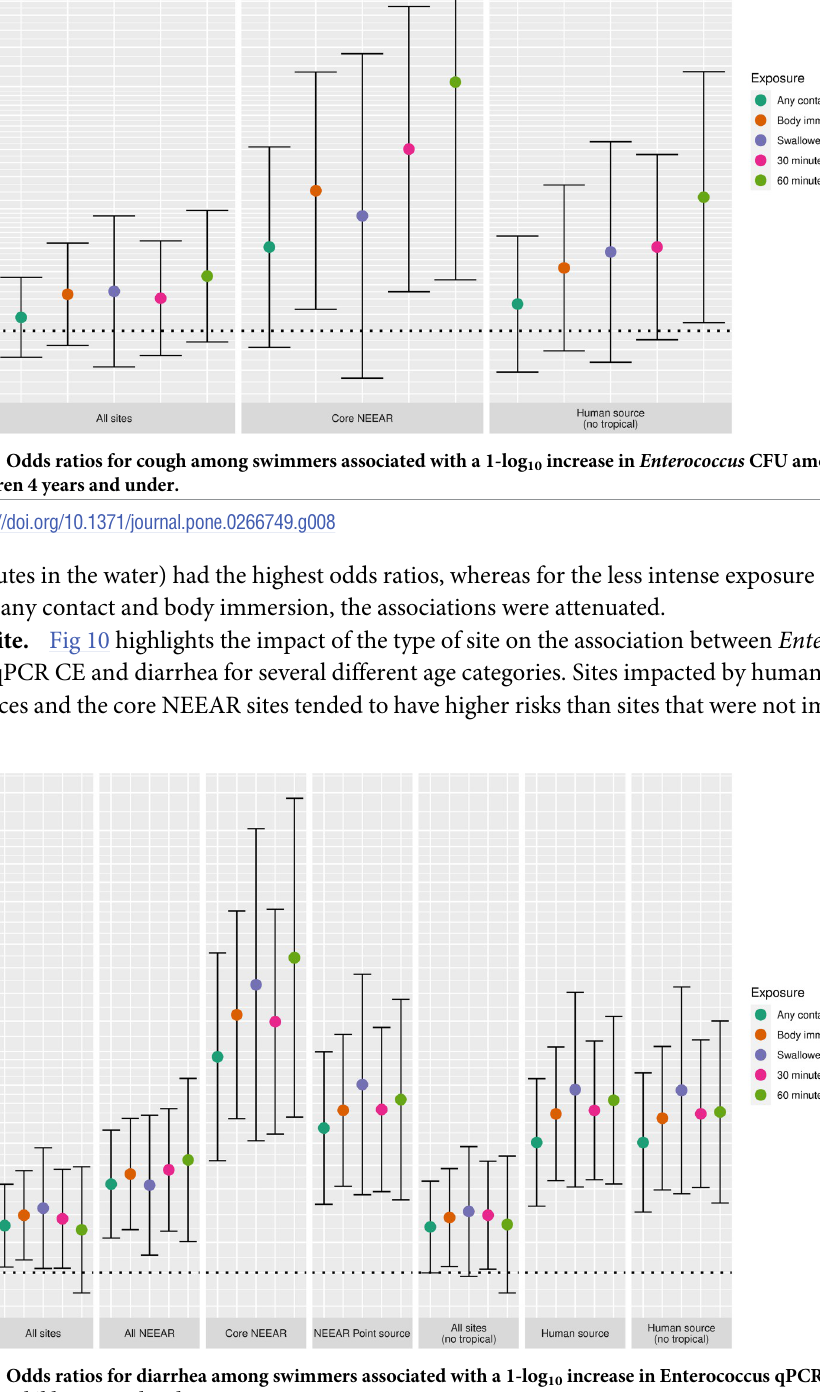
Fig 9. Odds ratios for diarrhea among swimmers associated with a 1-log 10 increase in Enterococcus qPCR CE among children 10 and under.